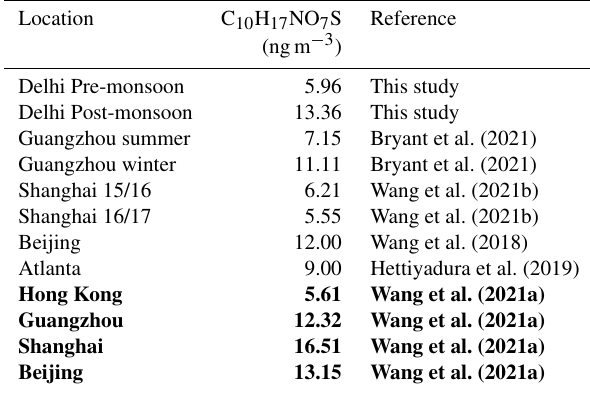
Table 2. Comparison of C 10 H 17 NO 7 S concentrations across differ- ent locations. Locations and concentrations in bold were quantified by authentic